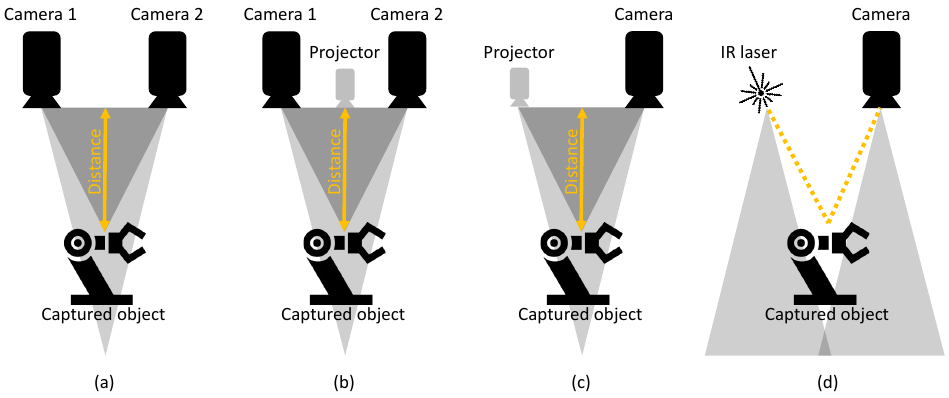
Figure 3. Depth camera variations. ( a ) Passive stereo vision. ( b ) Active stereo vision. ( c ) Structured light. ( d ) Time Of